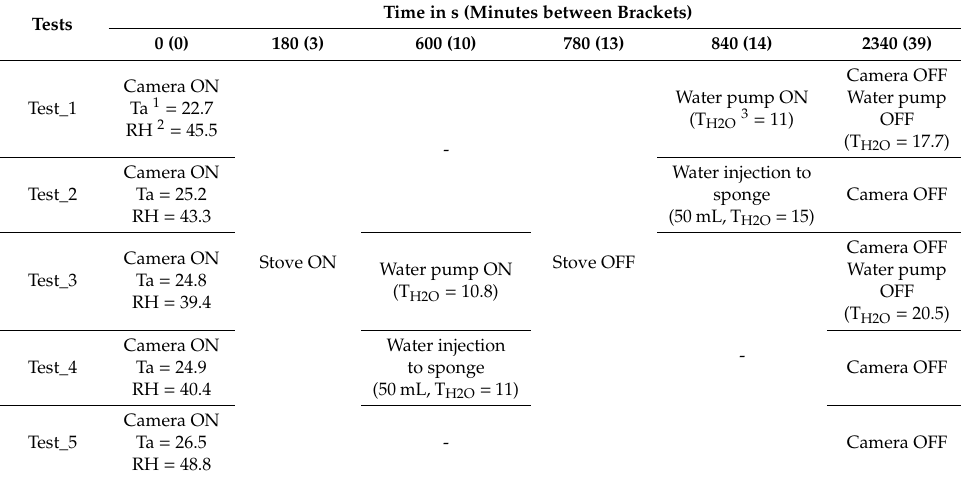
Table 2. Steps followed in the experiments